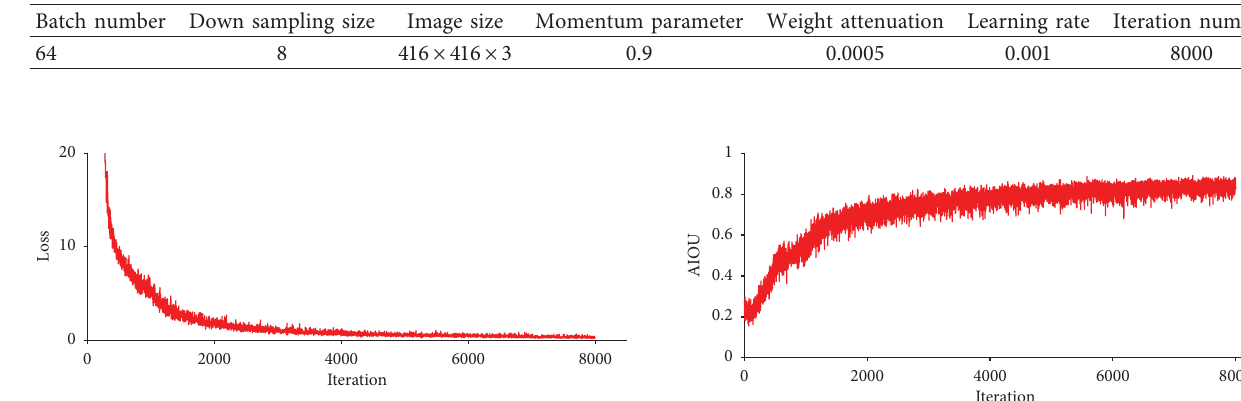
Figure 6: The iterative convergence process of the Loss curve for YOLOv2 network training.